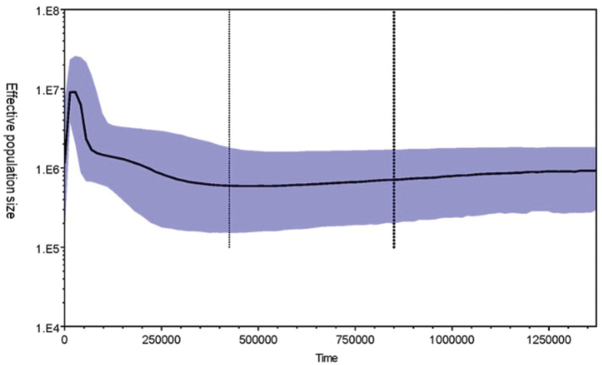
Bayesian skyline plot showing the effective female S.marmoratus population size through time. Black solid lines are median estimates of NeT (Ne=effective female population size; T=generation time); blue shading represents the 95% confidence interval of NeT. The y-axis was plotted on a logarithmic scale.